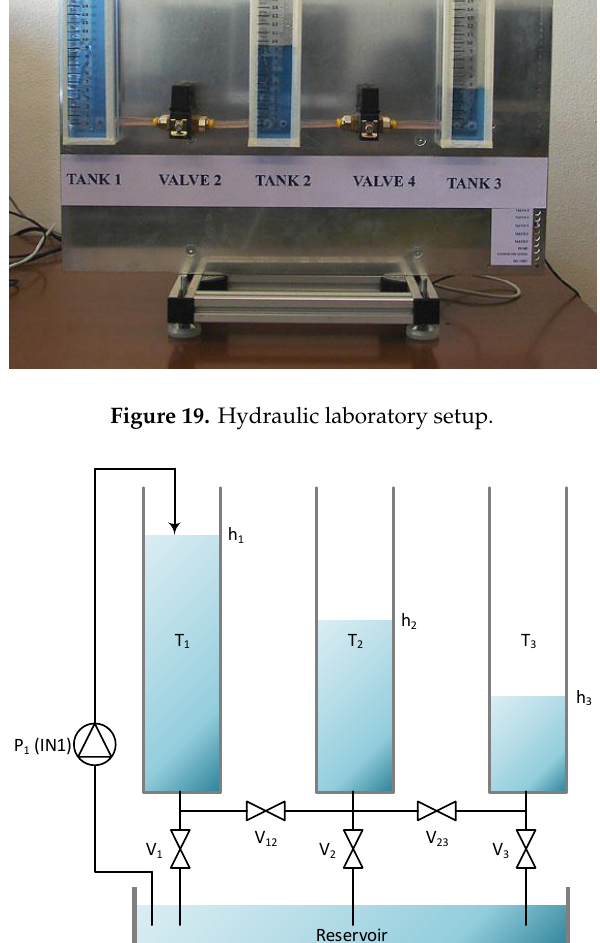
Figure 20. Schematic diagram of hydraulic laboratory setup.